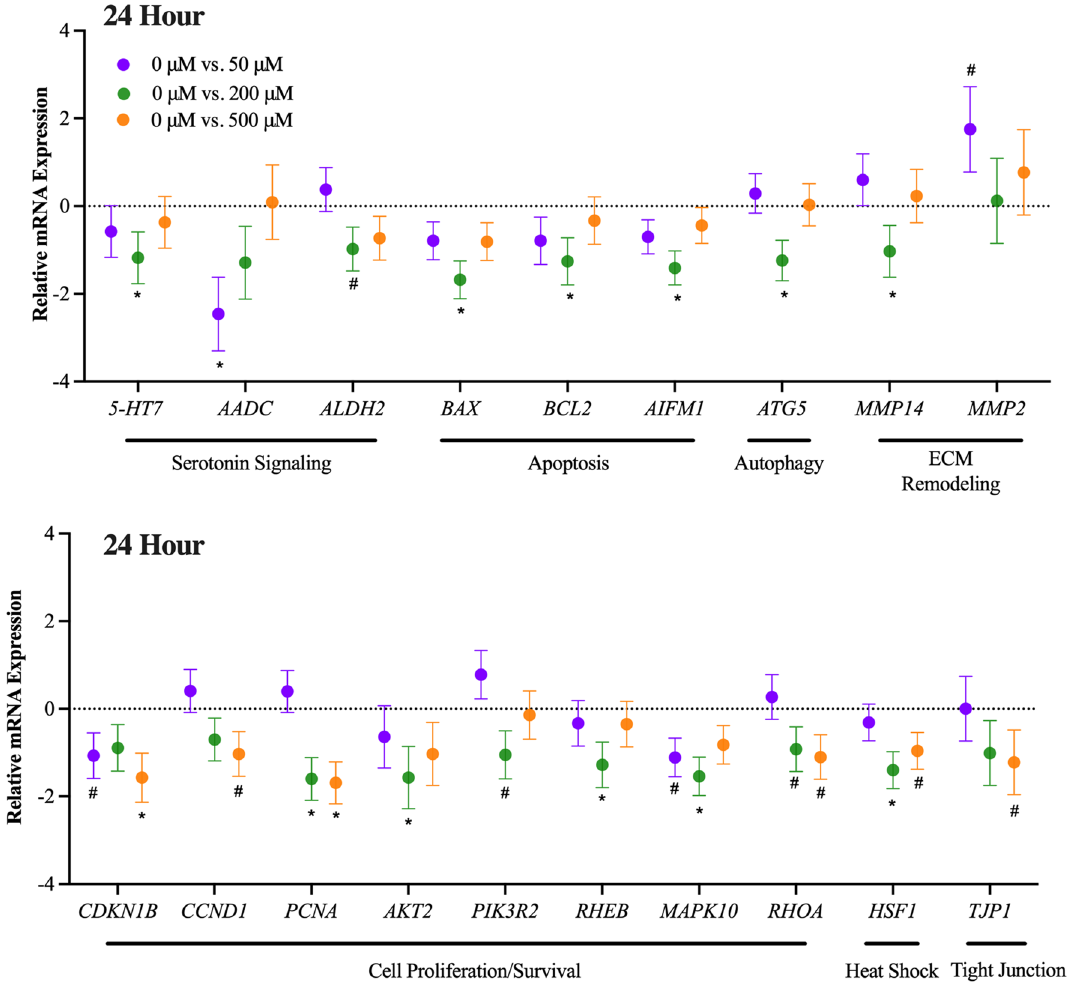
Figure 4. Main effect of 5-Hydroxy-L-tryptophan (5-HTP) dose. Gene expression of primary bovine mammary epithelial cells (pBMEC) cultured with 50, 200 or 500 μM of 5-HTP for 24-h. Data is presented as relative mRNA expression (∆∆Ct = ∆Ct Dose 0 (CON) − ∆Ct Dose 50, 200 or 500)) ± standard error of the mean (SEM). Positive and negative ∆∆Ct indicates upregulation and downregulation, respectively. Significance declared at P value ≤ 0.05 (*) and (#) denotes a statistical tendency at 0.05 < P value ≤